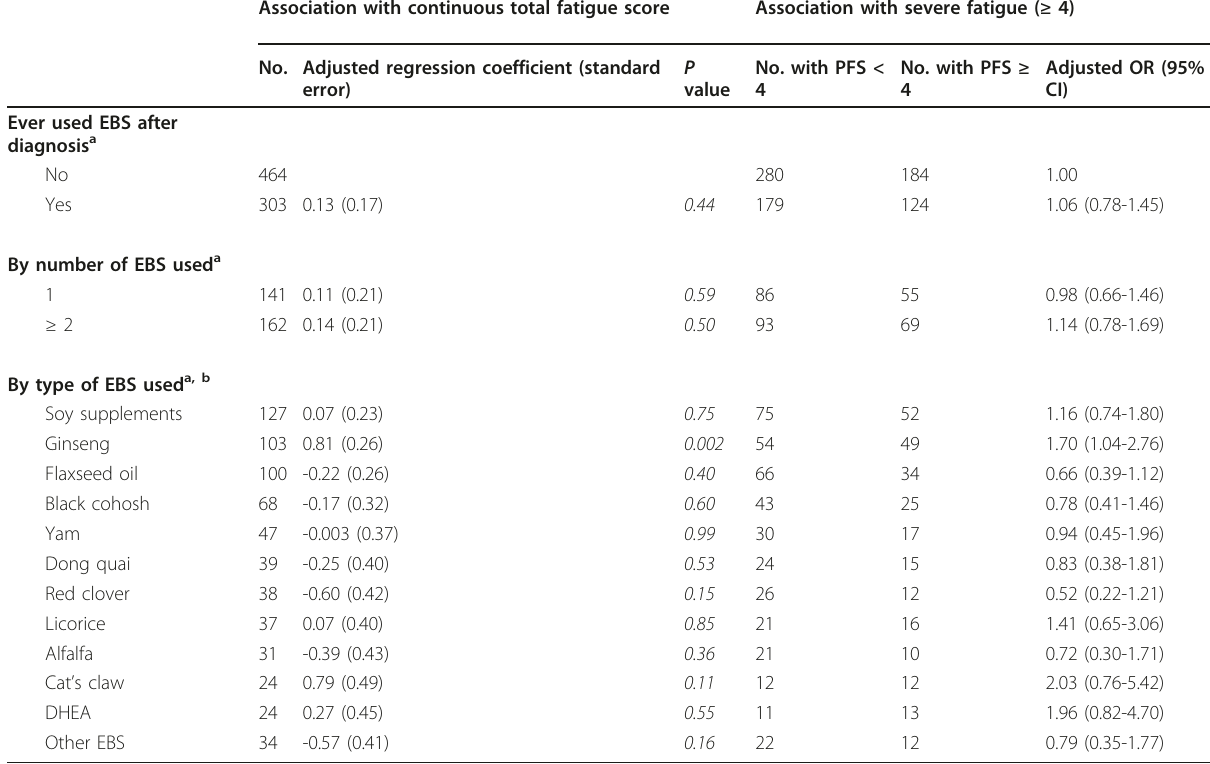
Table 3 The association between estrogenic botanical supplement (EBS) use and total fatigue score Association with continuous total fatigue score Association with severe fatigue ( ≥